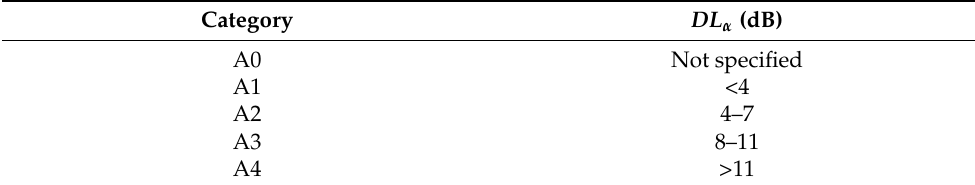
Table 1. Sound absorption categories